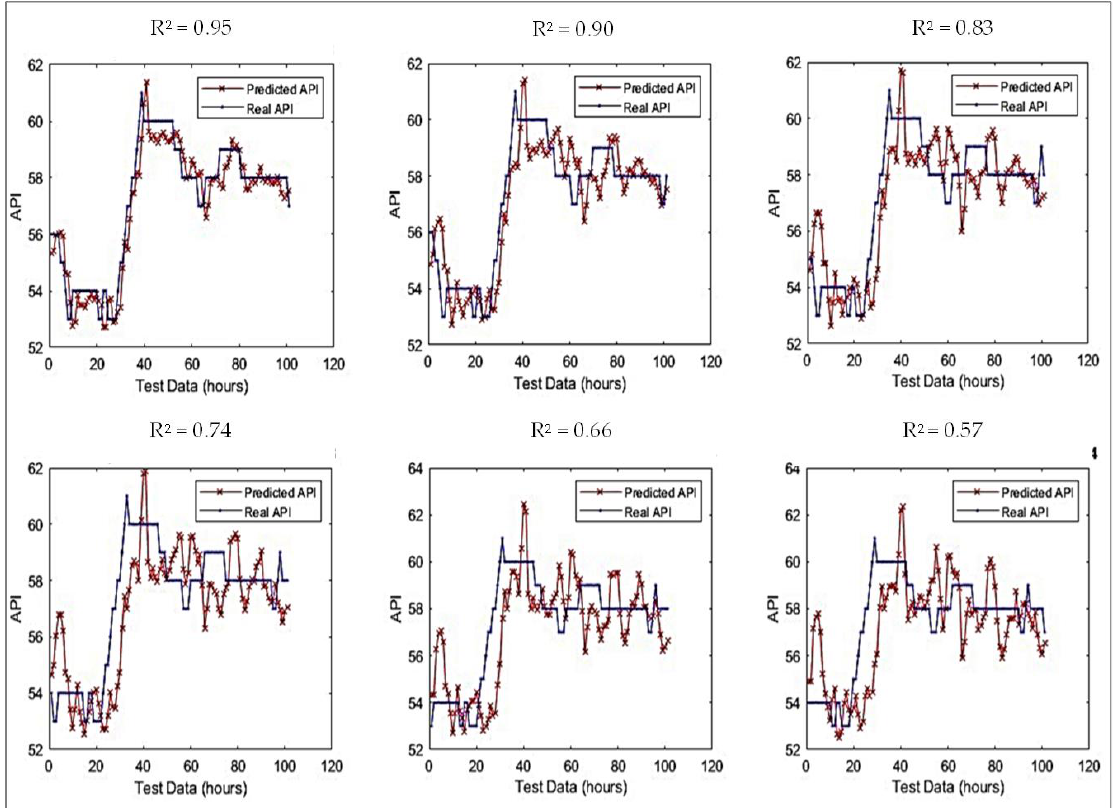
Figure 7. The actual and predicted API for different R 2 values.